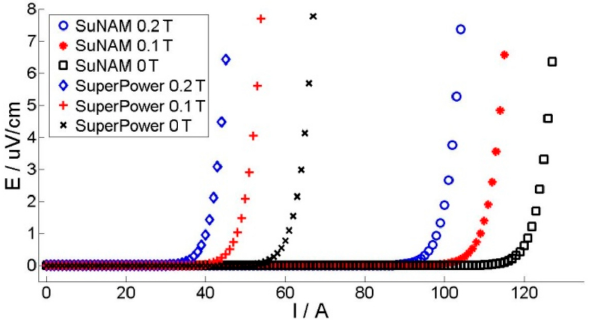
Figure 3. E-I curves under a DC field of 0.2 T, 0.1 T, or 0 T for SuNAM and SuperPower coils.